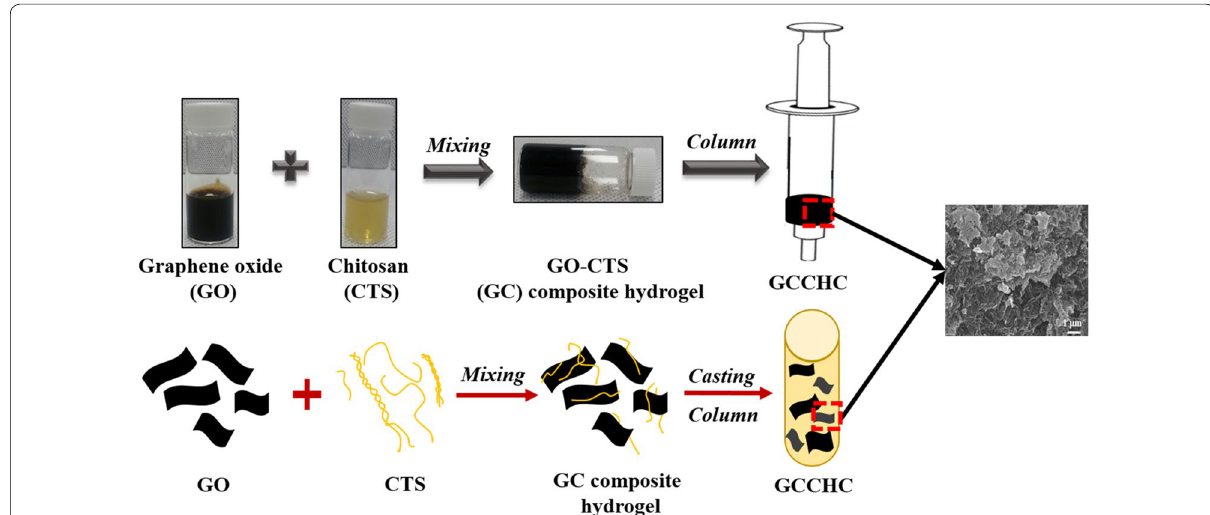
Fig. 1 The preparation process of GCCHC